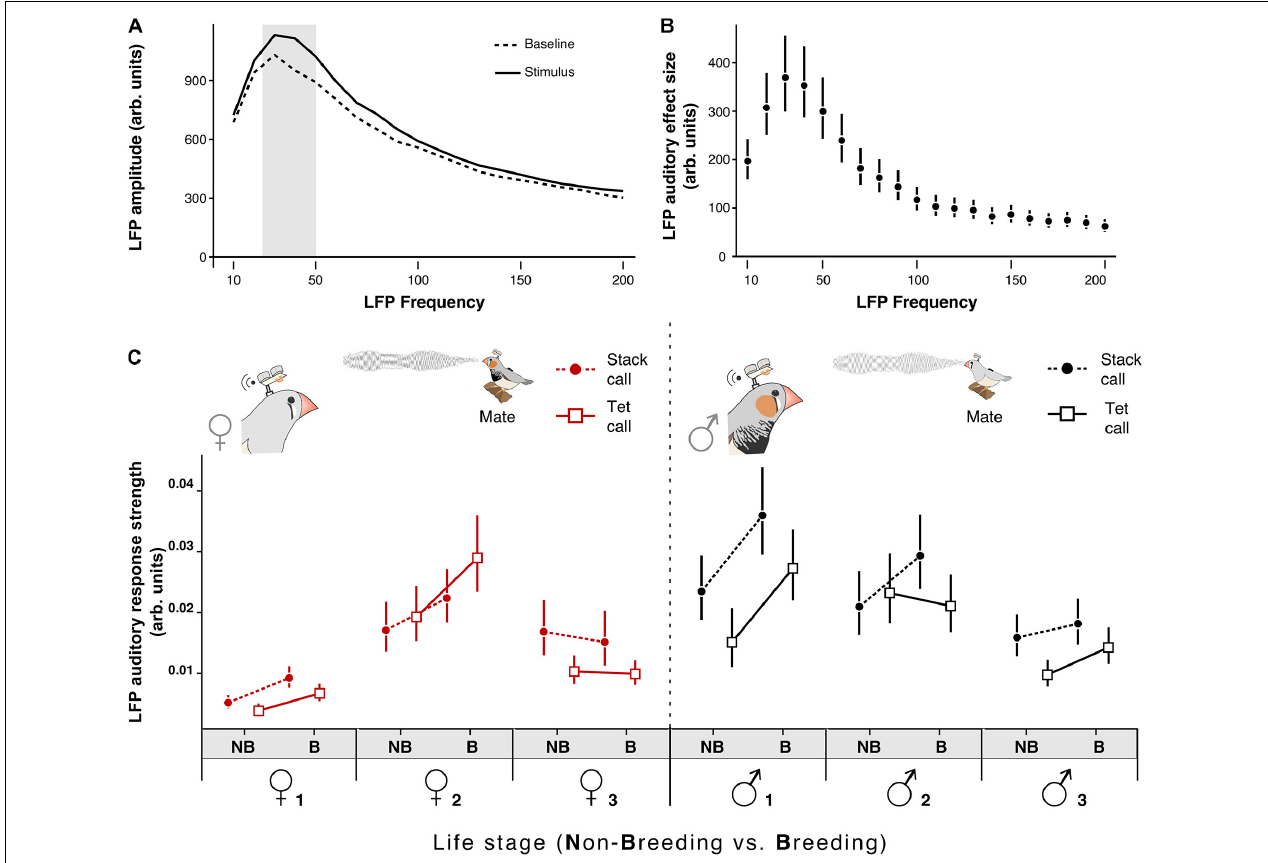
FIGURE 3 | Onset of breeding conditions affects the NCM auditory responses. (A) Average LFP amplitude during Baseline and during the auditory Stimulus from a representative individual; the band of 30–50 Hz is the one with the highest amplitude modulation. (B) Average auditory amplitude modulation (Auditory-Stimulus) from a representative individual (C) Females’ (left) and males’ (right) LFP auditory auditory response strength (for the 30–50 Hz band) in response to the two most frequent contact vocalizations (stack call [circles and dotted line]; tet calls [squares and solid lines]) of their mate in the non-breeding (NB) and breeding (B) life stage. Circles and squares represent the estimated mean from the model and vertical bars the 95% CrI. A probability of difference higher than 95% can be assumed if the estimates of a group do not overlap the CrI of the other